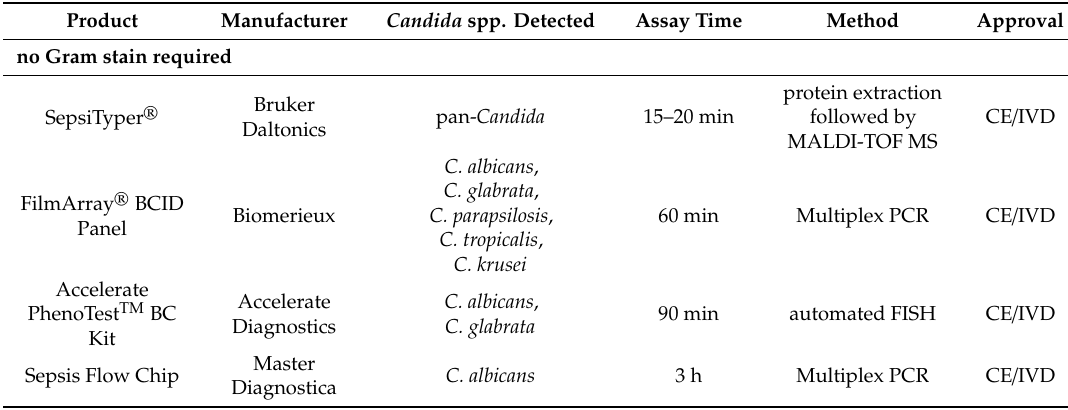
Table 1. List of blood culture-dependent